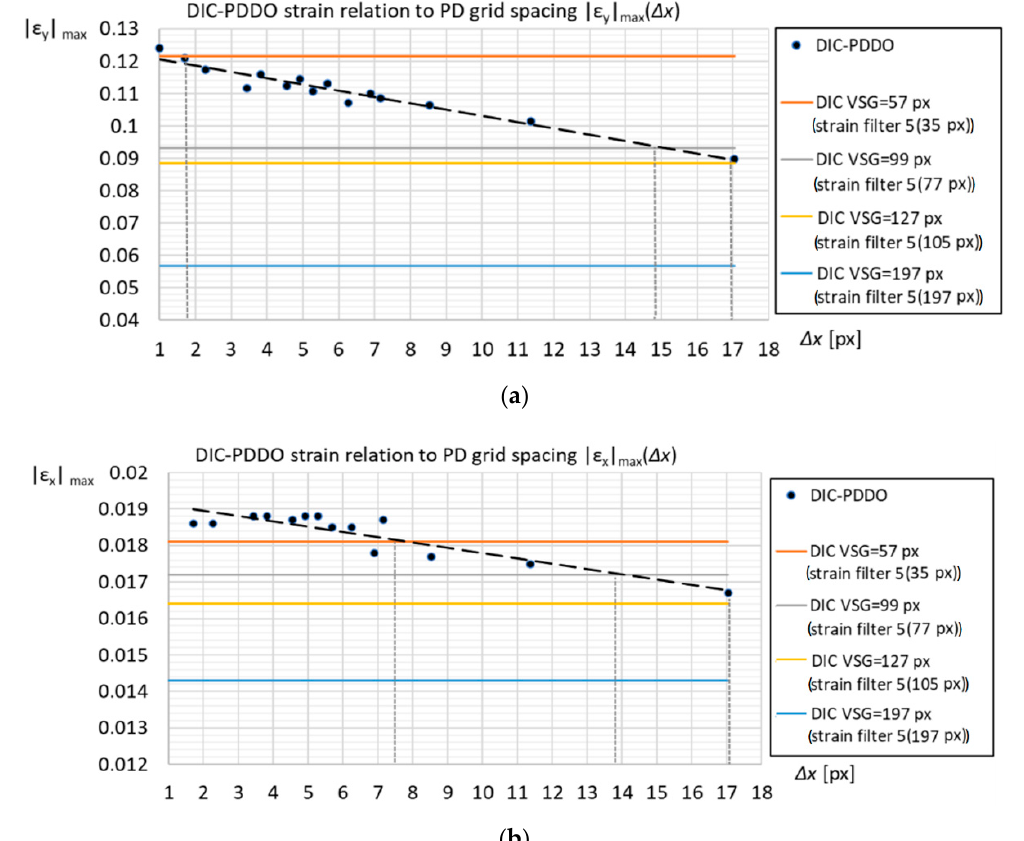
Figure 7. Effect of the PD grid spacing ∆ x on the strain values computed on in-house tensile experiment specimen surface by the DIC-PDDO method ( δ = 3.1 ∆ x ): ( a ) ε y strains, ( b ) ε x